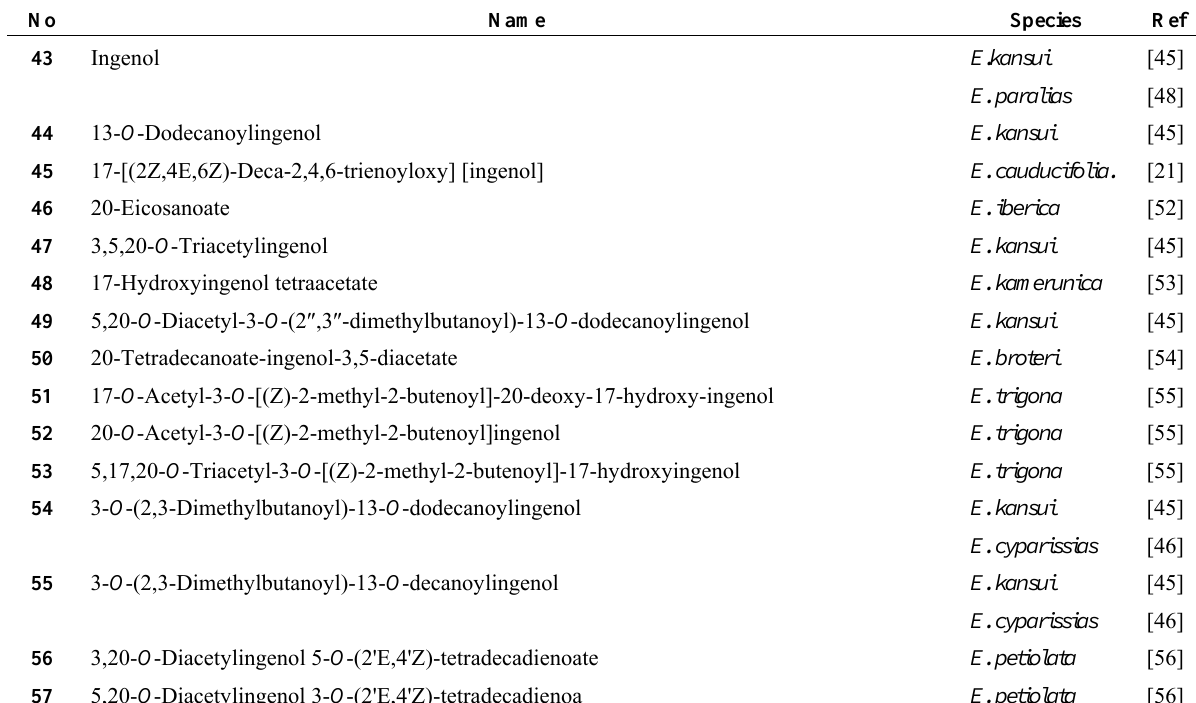
Table 2. Ingenane diterpenoids isolated from Euphorbia